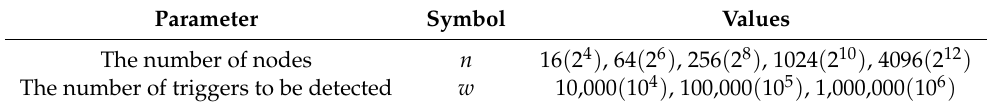
Table 2. The parameters for the simulation.